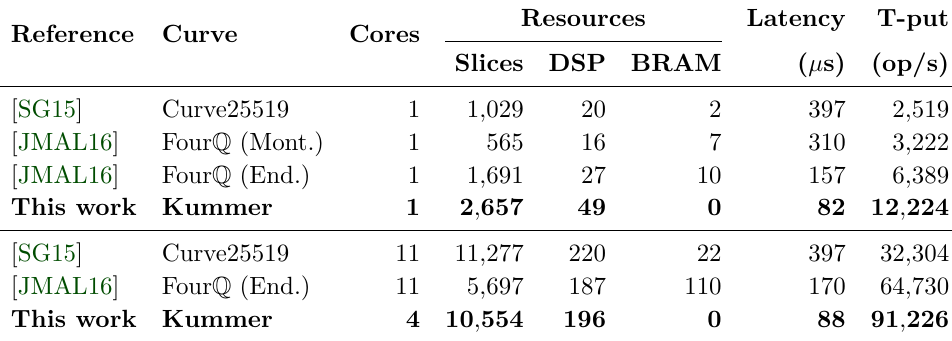
Table 7: Comparison of single- and multi-core architectures of variable-base scalar multi- plications featuring a 128-bit security level on a